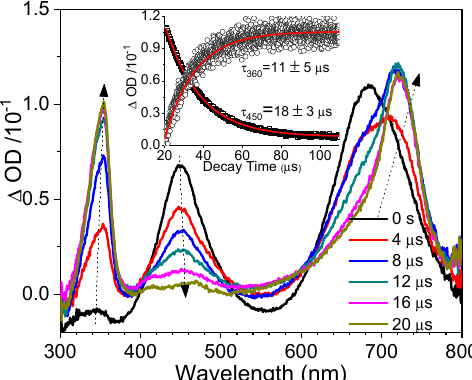
Figure 1. ns-TA of 1 acquired in 1:1 MeCN:1 mM HClO 4 solution after 266 nm irradiation. The kinetics at 450 and 360 nm are shown in the insert.